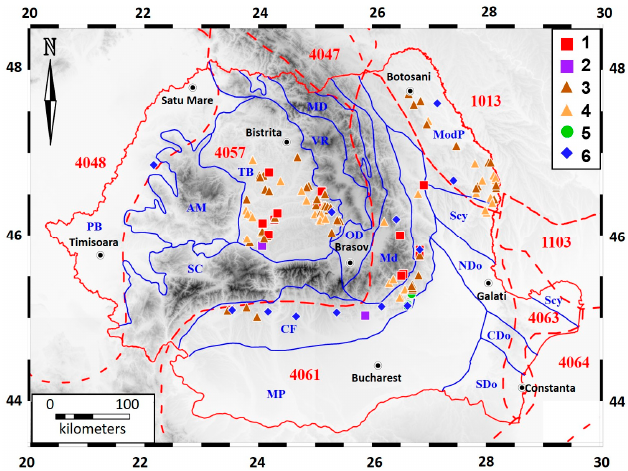
Figure 2. Distribution of the active and inactive seeps included in the HYSED-RO database in relation to the geologic provinces defined by the USGS (red dashed lines and numbers [45], and with the main structural units of Romania (blue lines and acronyms) [48]. 1013: Ukrainian Shield; 1103: Dobrogea Foreland; 4047: North Carpathian Basin; 4048: Pannonian Basin; 4057: Transylvania; 4061: Carpathian-